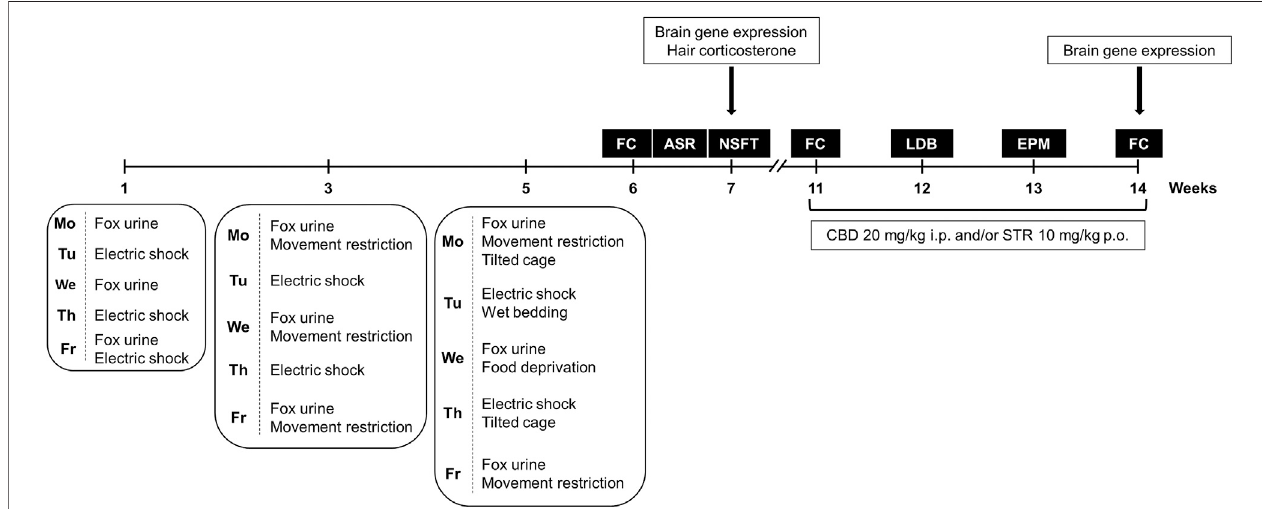
FIGURE1| Timelinediagramoftheexperimental procedureusedforthedevelopmentoftheanimalmodelofpost-traumaticstressdisorder(PTSD)(weeks1 – 5)to evaluate PTSD-induced behavioral and neurobiological alterations under basal conditions (weeks 6 and 7), and to analyze the pharmacological actions of cannabidiol (CBD, 20 mg/kg, i.p.) and/or sertraline (STR, 10 mg/kg, p.o.) on long-lasting PTSD disturbances (weeks 11 – 14). FC: Fear Conditioning, NSFT: Novelty Suppressed Feeding Test, LDB: Light-Dark Box, EPM: Elevated Plus Maze.